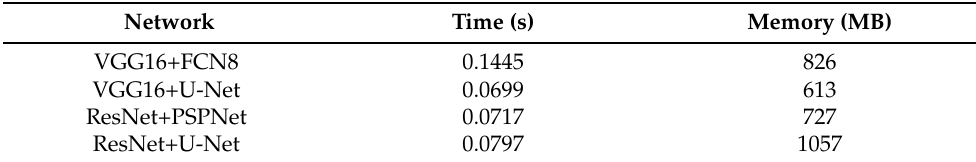
Table 10. Temporal and spatial requirements of each architecture.